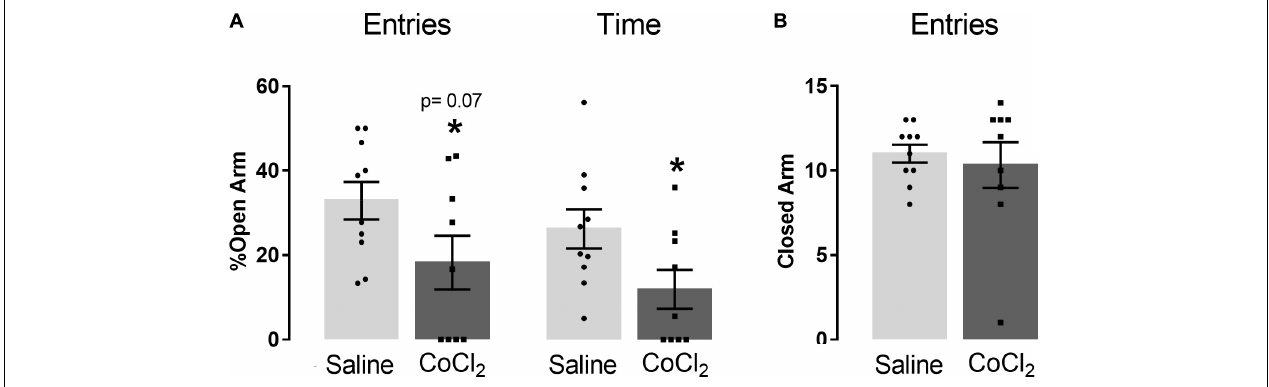
FIGURE 4 | Anxiogenesis induced by left PrL inhibition (with local injection of CoCl 2 ). (A) Effects of CoCl 2 injection into the left PrL on the percentage of open-arm entries and percentage of open-arm time, and (B) frequency of closed-arm entries in the EPM of saline ( n = 10) and CoCl 2 ( n = 9) groups. Bars with scatter dot plot represent mean ( ± SEM). * p < 0.05 compared with the saline group. CoCl 2 , cobalt chloride.